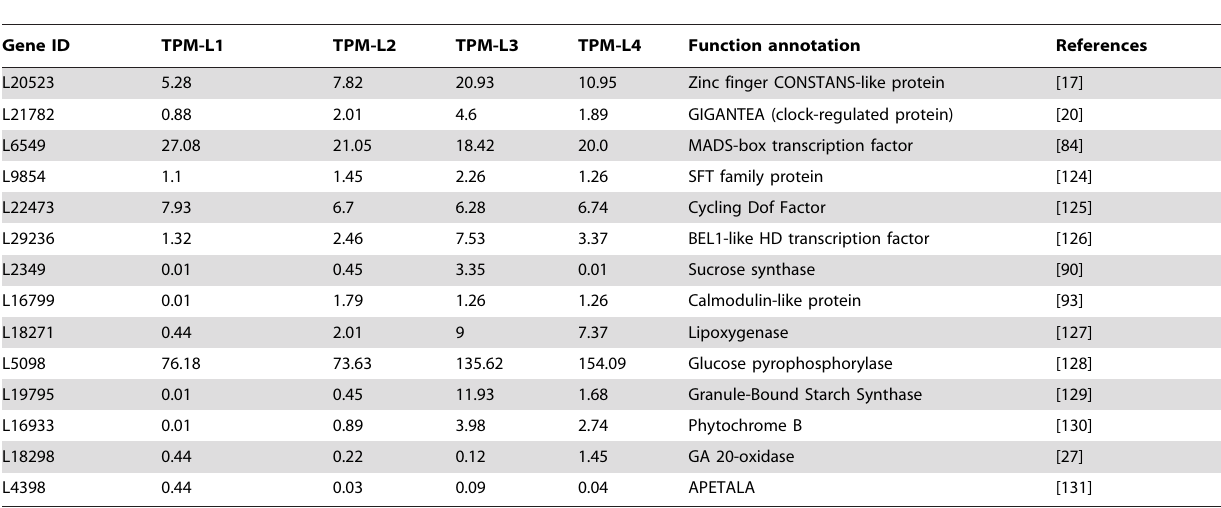
Table 6. Expressed abundance of some rhizome formation-related genes identified